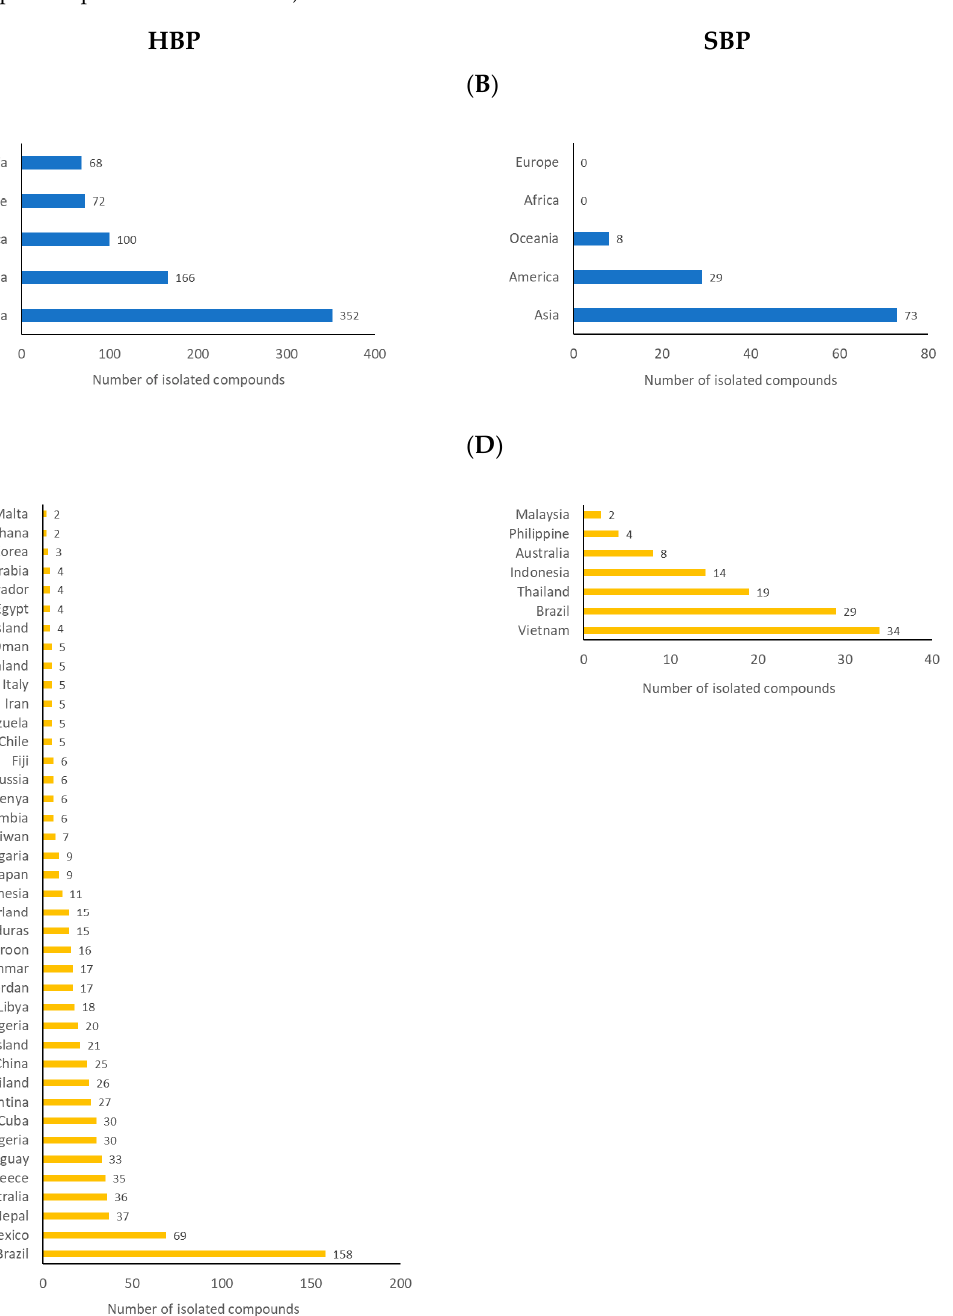
Figure 4. Number of compounds isolated from propolis ( n = 578) (Blue: HBP ( n = 502); orange: SBP ( n = 100)) (overlapped compounds were removed).